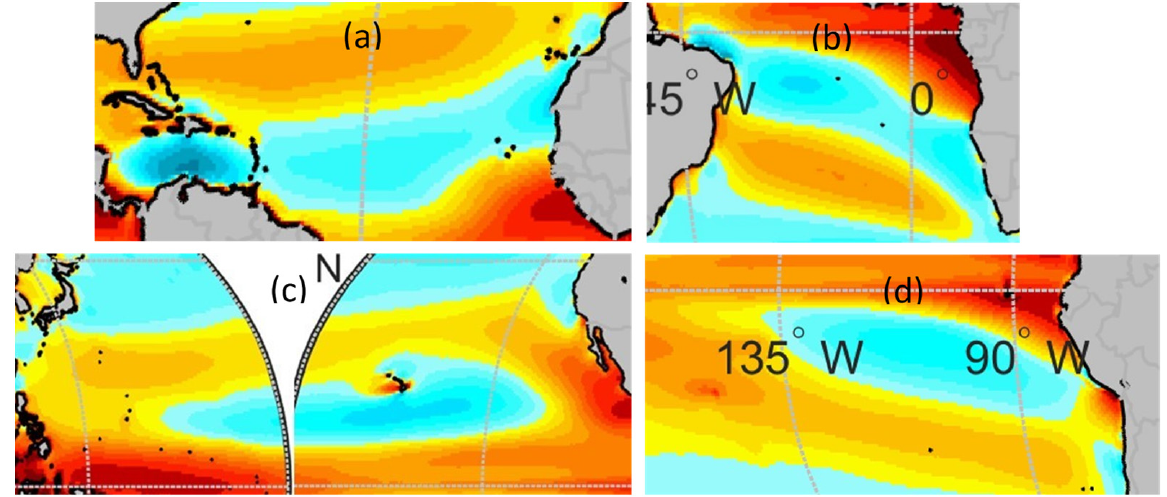
Figure 8. Trade wind belts distribution of annual mean operability, µ 0 . ( a ) North Atlantic, ( b ) South Atlantic, ( c ) North Pacific, and ( d ) South Pacific. The Indian Ocean has been shown in Figure 7a. Color scale the same as Figure